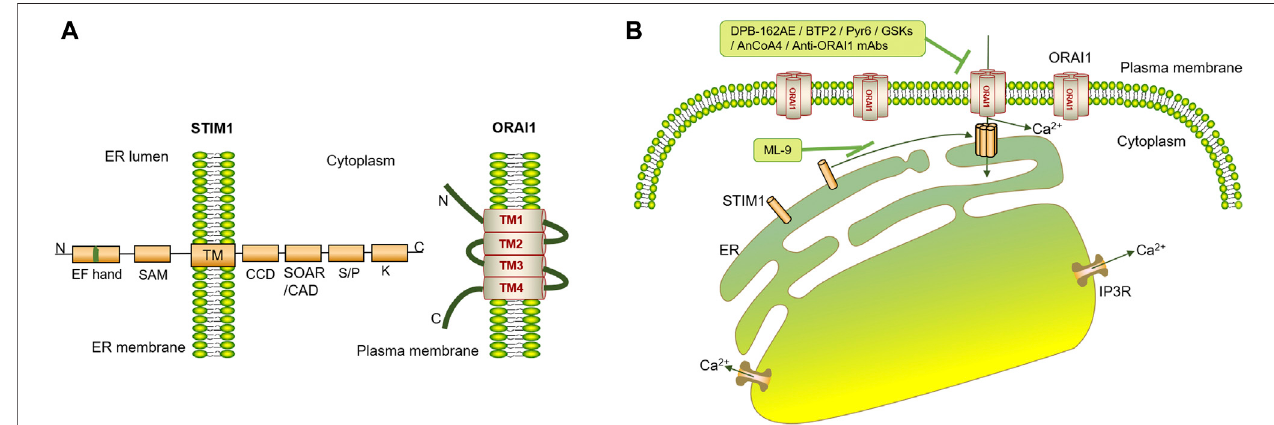
FIGURE 1 | Schematic diagram of ORAI1- and STIM1-mediated SOCE. (A) STIM1 contains two EF-hands, a sterile α motif (SAM) domain, a single transmembrane segment, a coiled-coil domain (CCD), a STIM-ORAI activating region (SOAR) or CRAC activation domain (CAD), a serine- or proline-rich segments, and a polybasic (PB) C-tail. ORAI1 contains four transmembrane helices (TM1-TM4), intracellular N-terminal and C-terminal epitope tags, and an extracellular epitope tag that is introduced into the TM3-TM4 loop. (B) IP3R binds to IP3 upon triggering by agonists, leading to the release of Ca 2+ from the ER. STIM1 residing in the ER senses the Ca 2+ decrease in the ER and initiates conformational changes and oligomerization to expose SOAR/CAD and the PB C-tail. Activated STIM1further multimerizesand migratestoward thePM, interactswiththeintracellular regions ofORAI1,gates and opens ORAI1 directly toenable rapidly uptake of Ca 2+ . SOCE-targeted inhibitors, such as DPB-162AE, BTP2, Pyr6, GSKs, AnCoA4, Anti-ORAI1 mAbs and so on, are demonstrated to inhibit ORAI1, and ML-9 is con fi rmed to inhibit STIM1